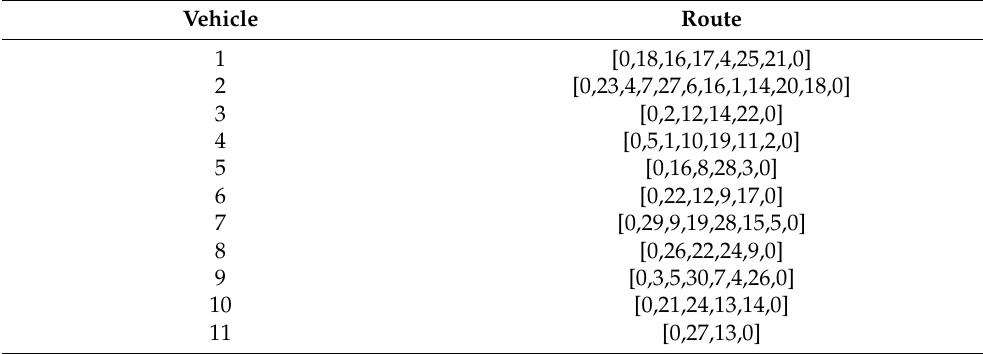
Table 3. Algorithm